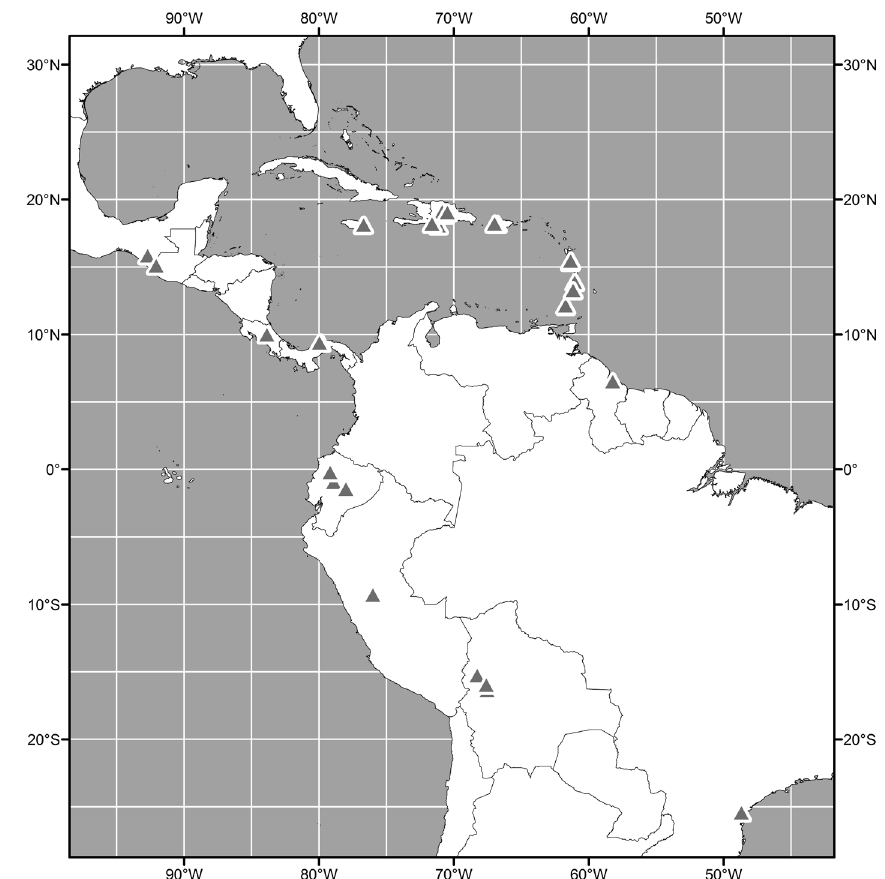
Figure. 24. Distribution map for Pectinifer aeneus